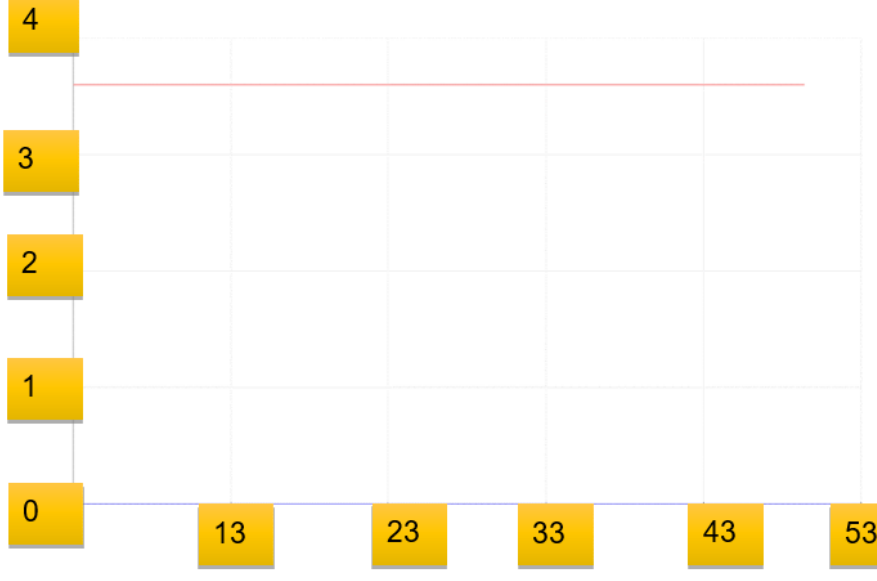
Figure 13. Smoke sensor at room temperature.